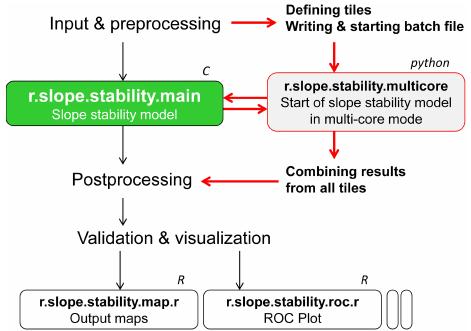
Figure 3. Logical framework of r.slope.stability. Plain text denotes steps directly implemented in the module r.slope.stability, and text in boxes denotes sub-modules. Italic letters indicate the program- ming environment used for the